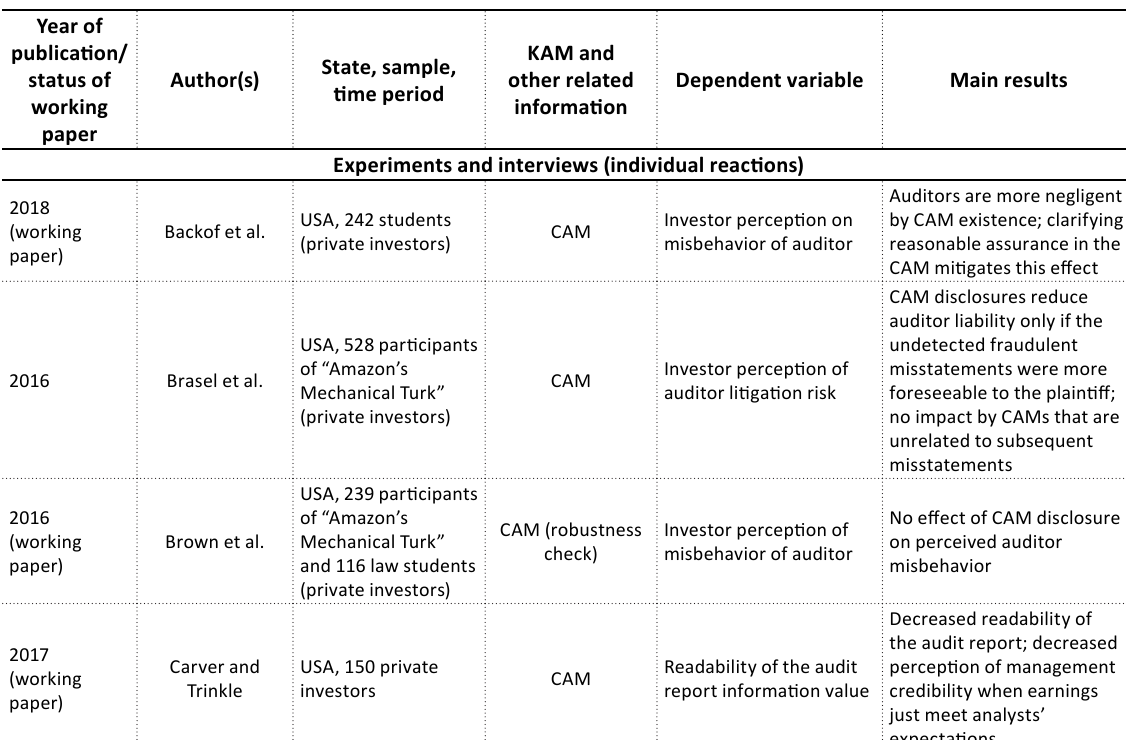
Table 3. Overview of empirical research regarding the impact of KAM and other related information on